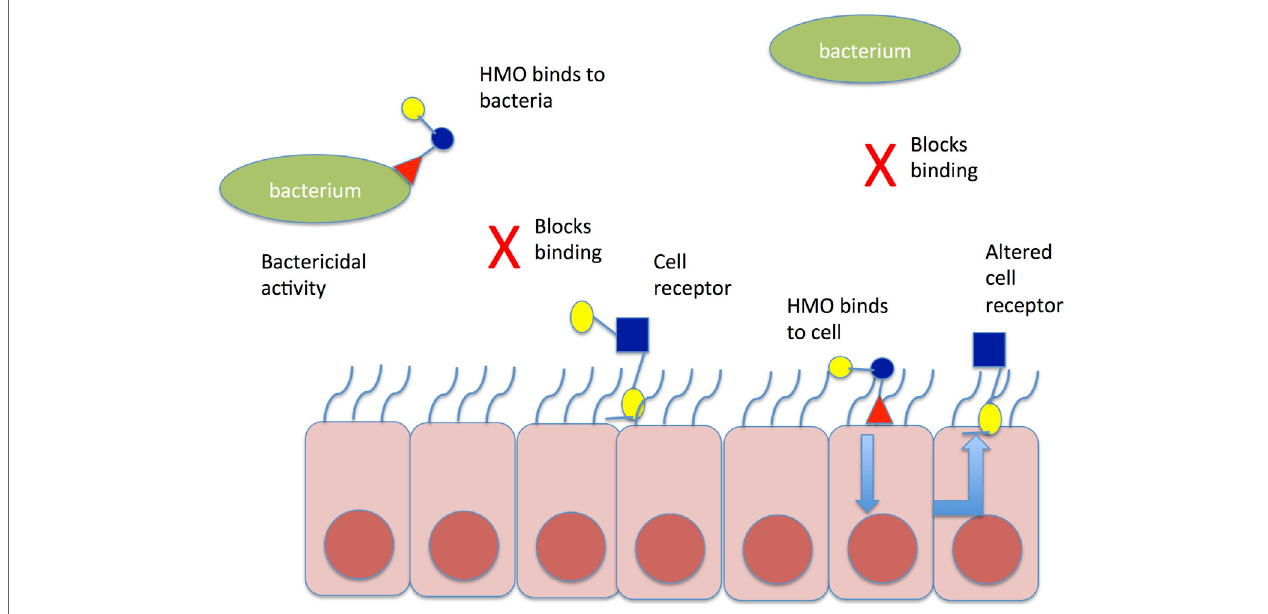
FiGURe 2 | Mechanism of action of HMO to prevent aberrant pathogen colonization. HMO may bind directly to bacteria in the gut lumen causing conformational change in bacterial binding sites and preventing binding to cell receptors; alternatively, HMO may bind directly to gut epithelial cells causing altered expression of cell receptors, which prevent pathogen binding to gut epithelial cells. HMO, human milk